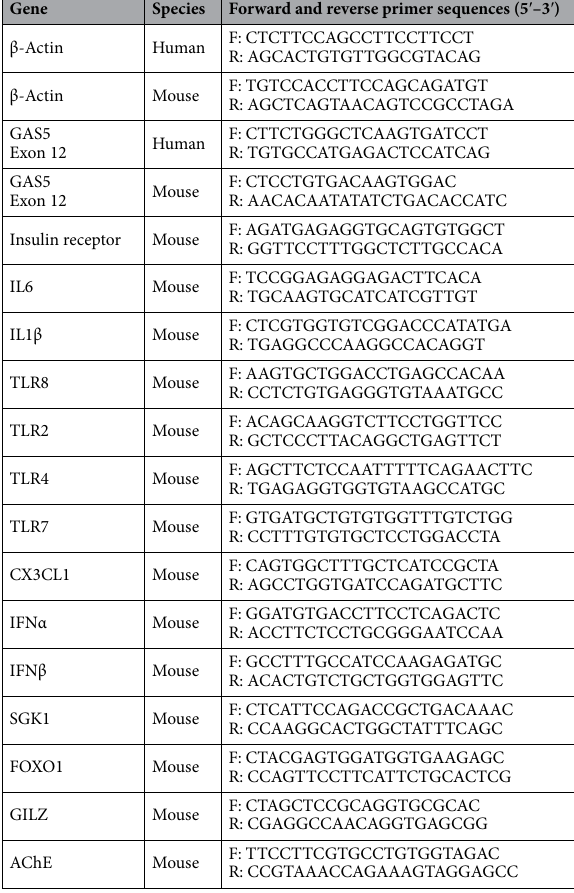
Table 1. Forward (F) and reverse (R) primer sequences shown 5 ′ to 3 ′ for genes amplified in qPCR with species